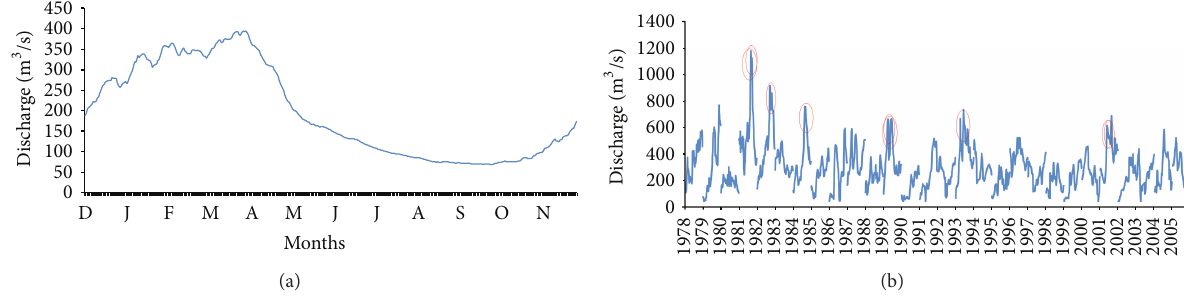
Figure 4: (a) Streamflow Climatology at Fazenda Santa Maria gauge station from 1978 to 2006, (b) Extremely high-streamflow events as per Table 1 during DJF seasons.